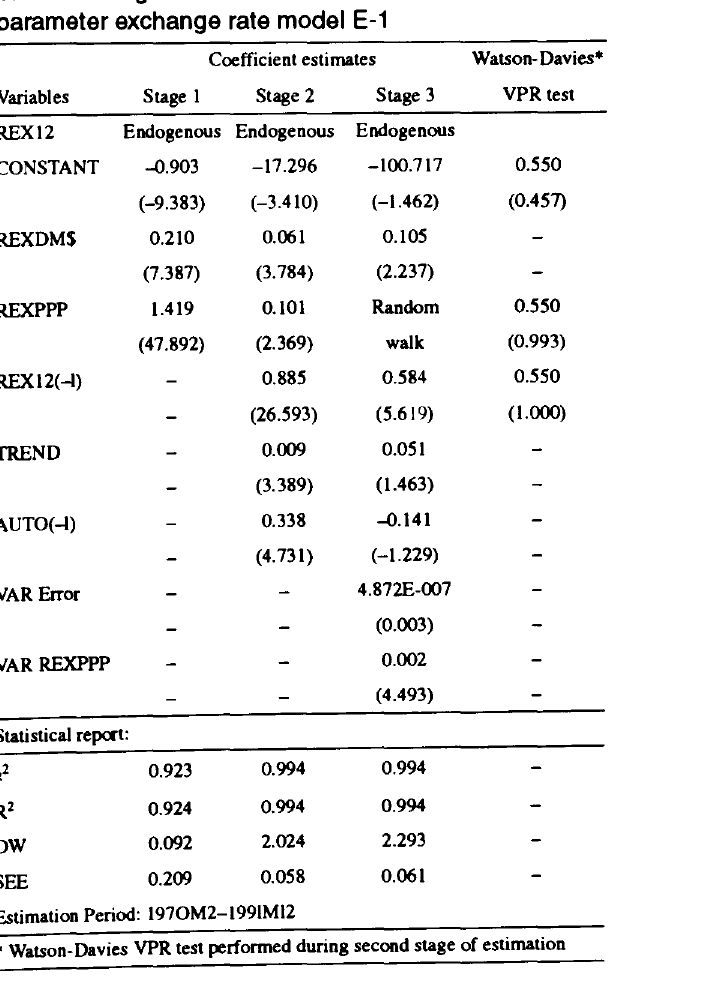
Table 1 Regression results for fixed and